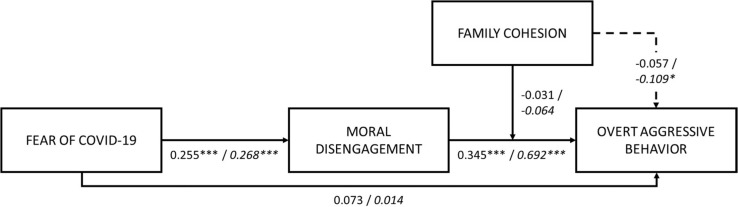
Model 3 Male/Female samples on overt aggression behavior. Male sample (RMSEA = 0.039, 90%CI [0.032, 0.045], CFI = 0.986, TLI = 0.982, SRMR = 0.046); Female sample (RMSEA = 0.037, 90%CI [0.033, 0.041], CFI = 0.980, TLI = 0.975, SRMR = 0.037); female sample coefficients given in italics.